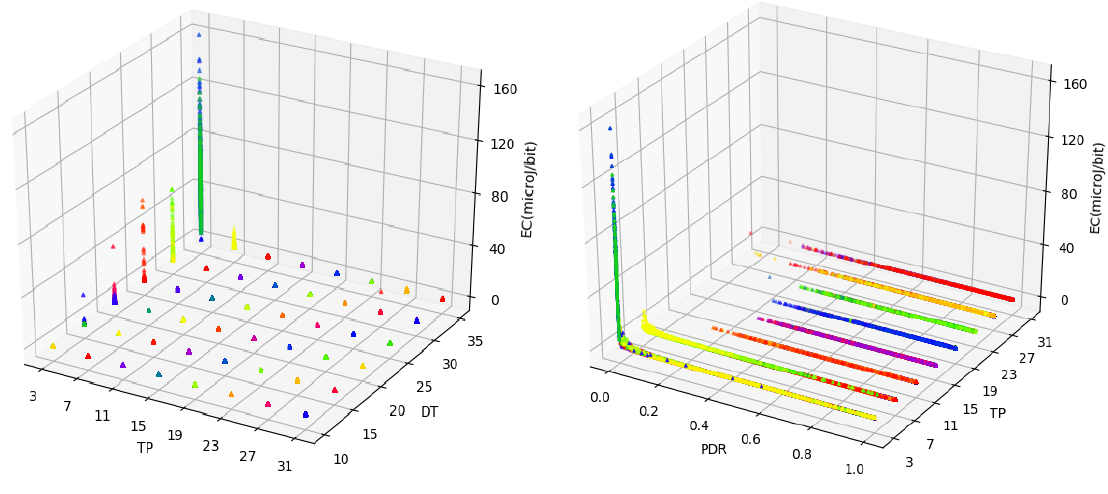
Figure 3. EC in relation to PDR , TP and DT